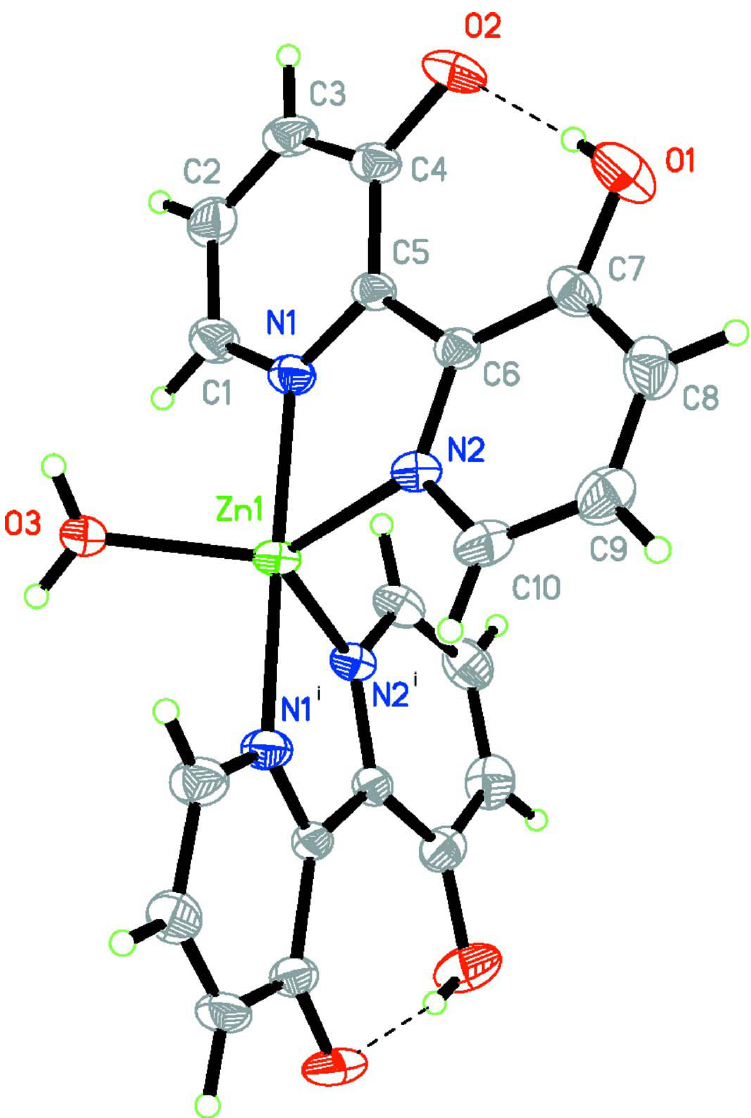
Figure 1 View of (I), showing displacement ellipsoids for the non-hydrogen atoms drawn at the 30% probability level. The hydrogen bond is indicated by a dashed line. Symmetry code: (i) -1/2 + x , -1/2 + y , 3/2 -